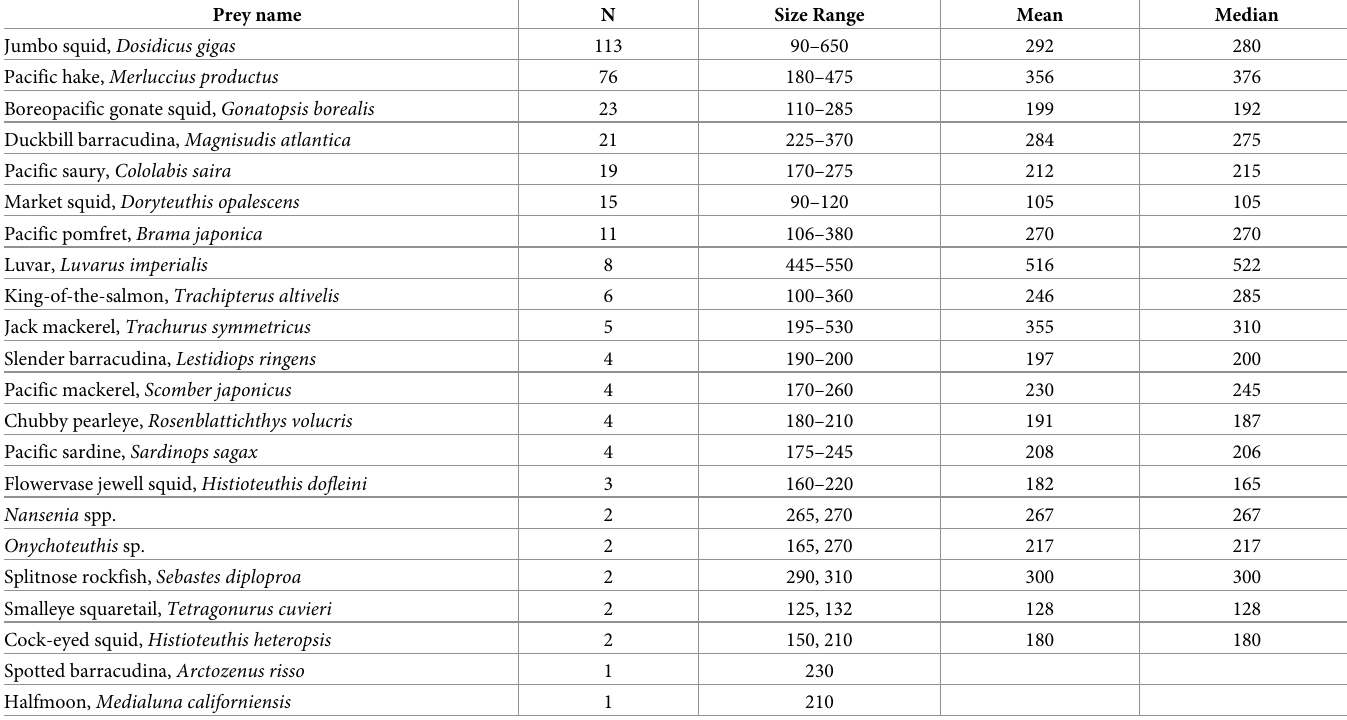
Table 2. Size range, mean and median for 328 swordfish prey items in a fresh and intermediate state of digestion. Prey name